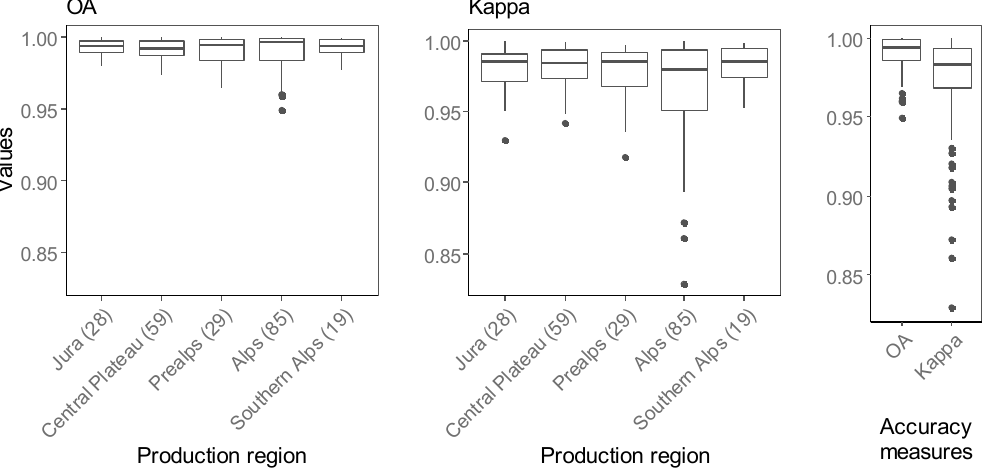
Figure 4. Distribution of the overall accuracies and kappa values of 220 subsets, based on the model results for the five NFI production regions. Number of subsets is given in brackets. Results were obtained using 10-fold cross-validation repeated five times.